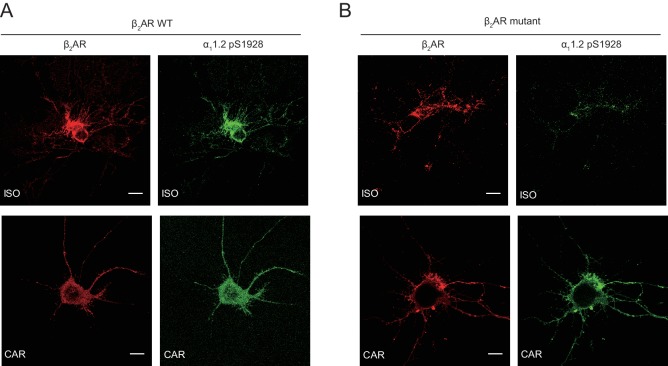
The mutant β2AR is selectively activated by carvedilol and promotes LTCC phosphorylation in neurons.β1AR/β2AR double knockout (DKO) hippocampal mouse neurons at 7–10 days in vitro (DIV) were cotransfected with FLAG-tagged β2AR WT (A) or mutant (B) and HA-tagged LTCC α11.2 subunit, 24 hr later cells were treated for 5 min with 1 μM ISO or CAR, fixed and labeled with anti-FLAG and a phospho-specific antibody for S1928 phosphorylated α11.2. Confocal images show mutant β2AR lost the ability of promoting LTCC phosphorylation upon ISO stimulation but remained the ability upon CAR stimulation in mouse neurons. Scale bar, 10 μm. Representative of n = 4, 6, 5 and 6 cells, respectively, three experiments.